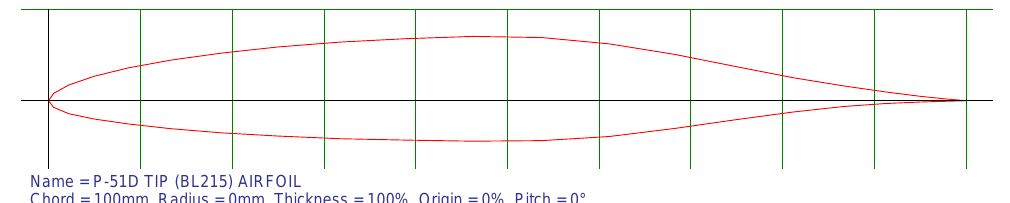
Figure 10. The original airfoil for both drone wings; generated by Airfoil Plotter